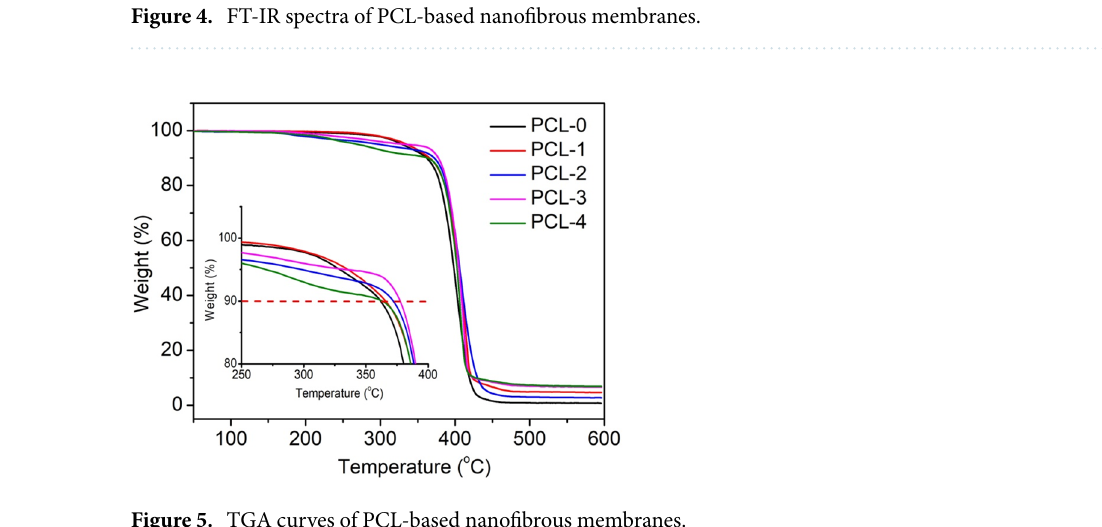
Figure 5. TGA curves of PCL-based nanofibrous membranes.